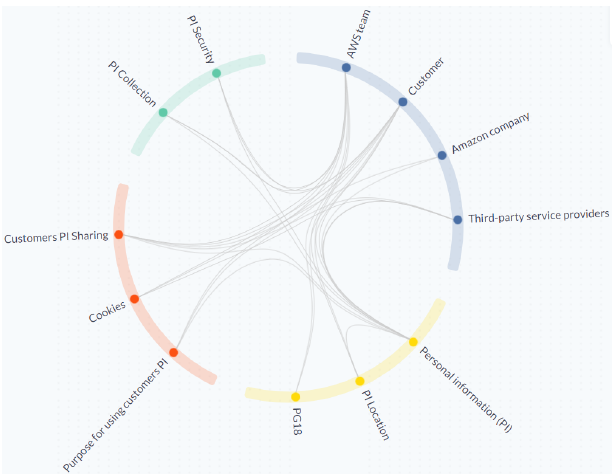
Figure 3. AWS keywords’ visual encoding using a